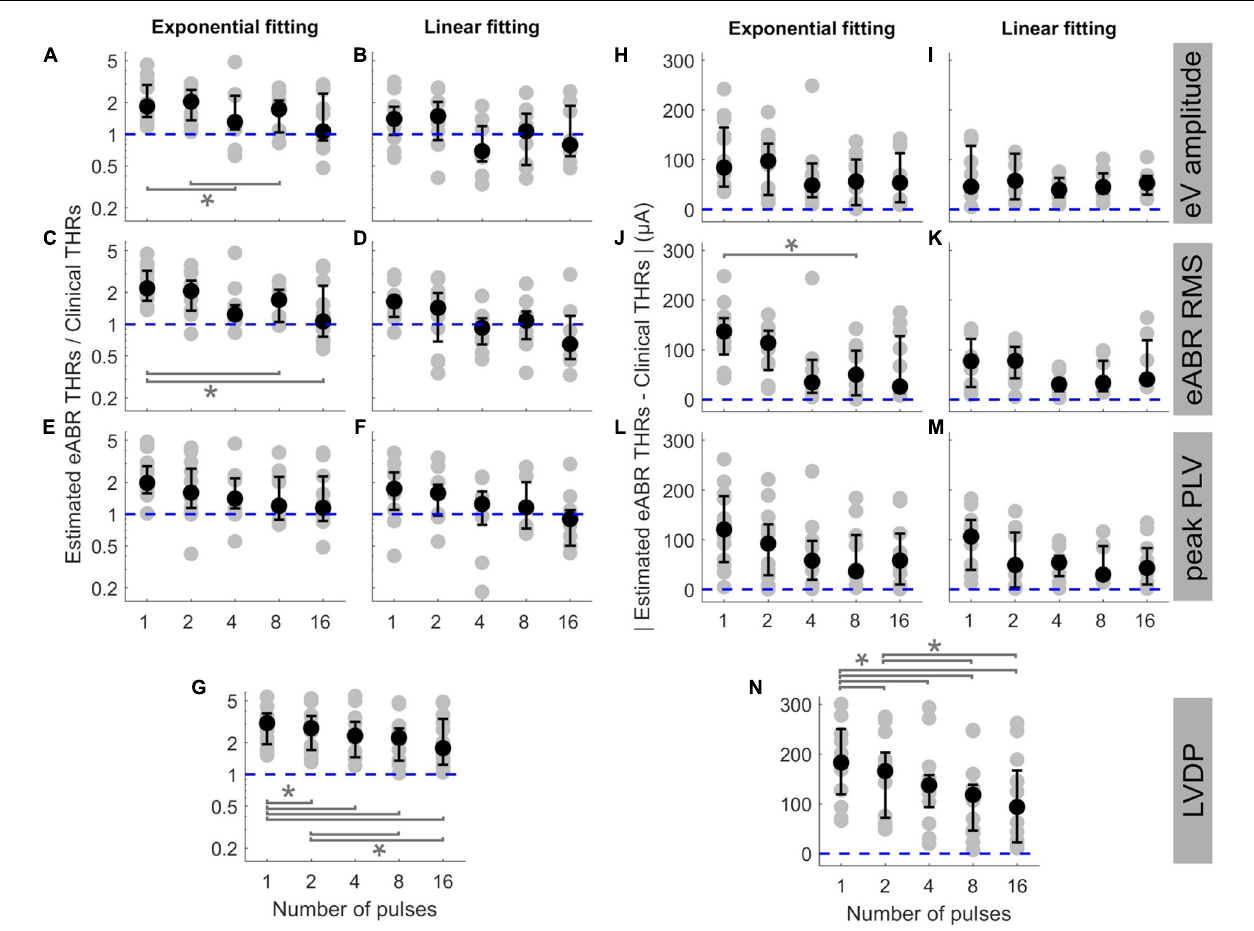
FIGURE 6 | The ratio of estimated eABR THRs to clinical THRs (A–G) and absolute difference between them ( H–N , respectively) as a function of number of pulses. The estimated eABR THRs were presented in Figure 5 , which were resulted from extrapolation of growth functions of wave eV (A,B,H,I) , eABR RMS value (C,D,J,K) , peak PLV (E,F,L,M) , and LVDP ( G,N , without any extrapolation). For each estimation method, an exponential function (left-side panels in each sub-figure) and a linear function (right-side panels in each sub-figure) were used for fitting. For the LVDP method, no estimation function was used. Data in gray shows results of individual subjects and data in black shows the corresponding median values across subjects. Lower and upper error bars show the mean 25th and 75th percentiles of median values from subsamples of growth functions, respectively. Asterisks show significant differences with 0.95 confidence intervals.